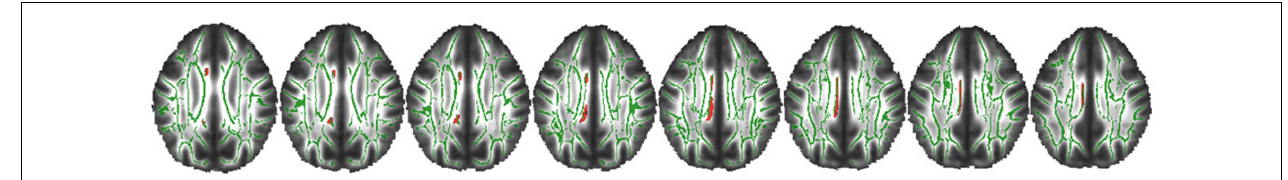
FIGURE 4 | Negative correlation between Y-BOCS obsession score and FA in the left CB. Axial slices. Clusters of voxels significantly different ( p < 0.05) are shown in red for FA in the WM. p = 0.009.